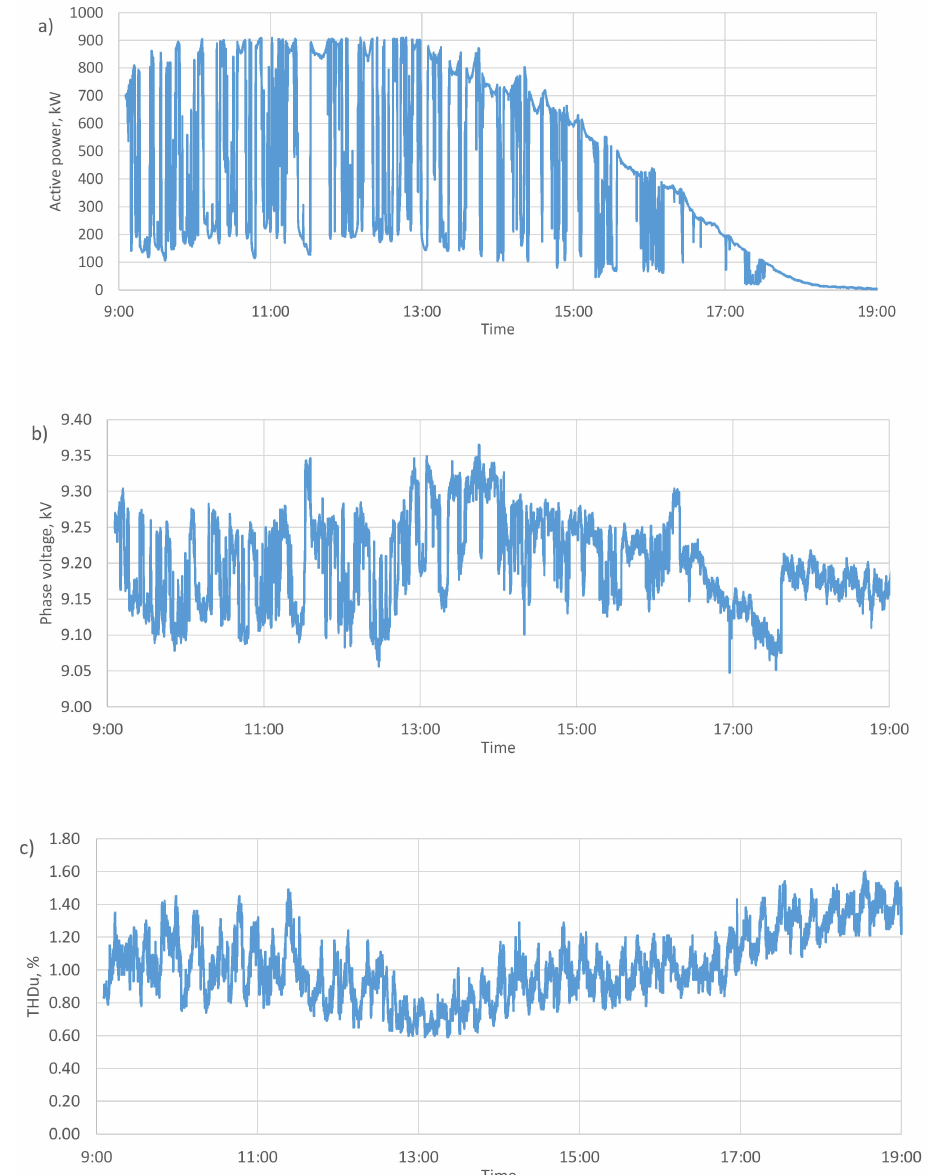
Figure 16. Exemplary one-day waveforms for the photovoltaic power station: ( a ) active power, ( b ) phase voltage—RMS value; ( c ) voltage